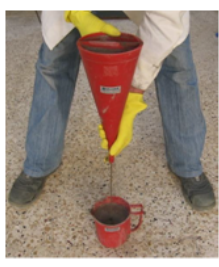
Figure 7: The Marsh cone test.